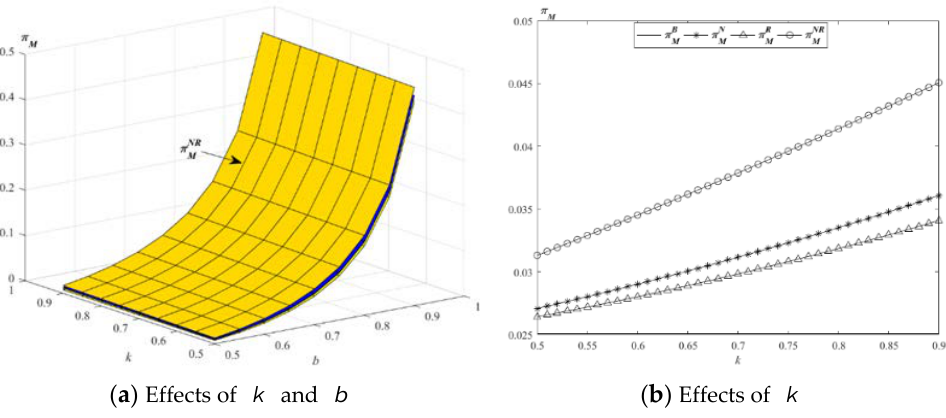
Figure 6. Impact of k and b on the optimal profit of M.